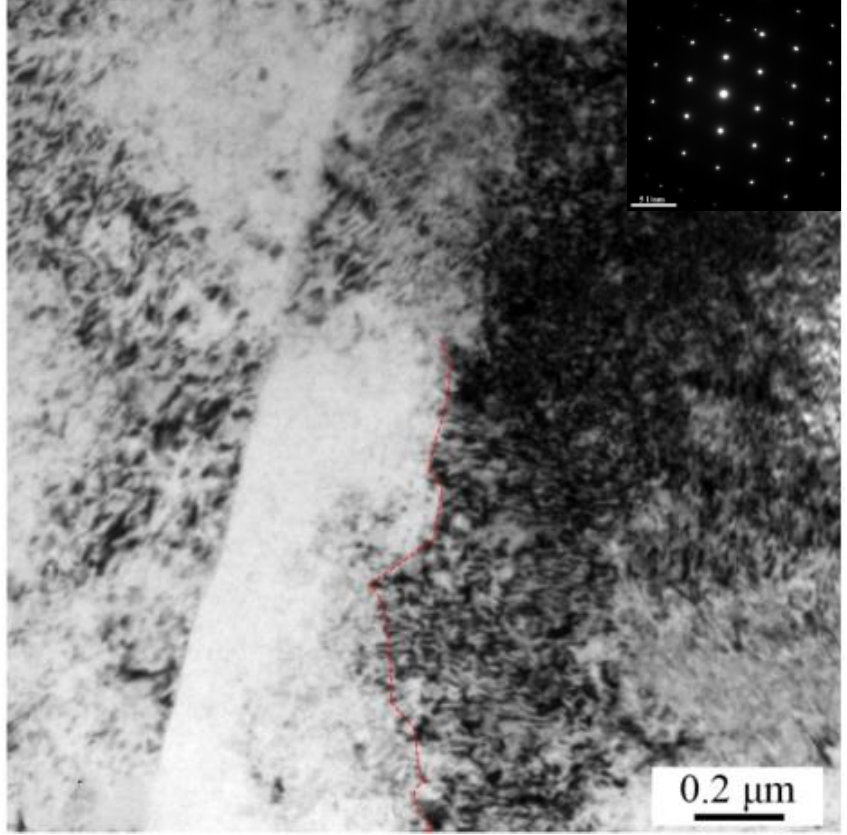
Figure 16. TEM bright-field image of the deformed W-state alloy at 77 K.